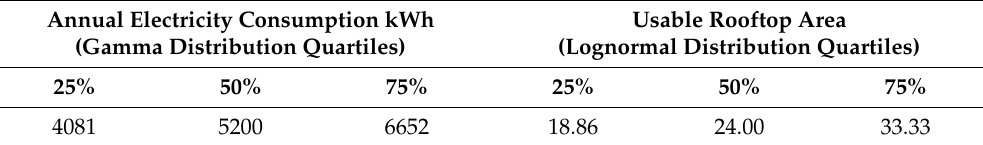
Table A6. Probability density functions of the random variables identifying an agent, common to all Cantons.